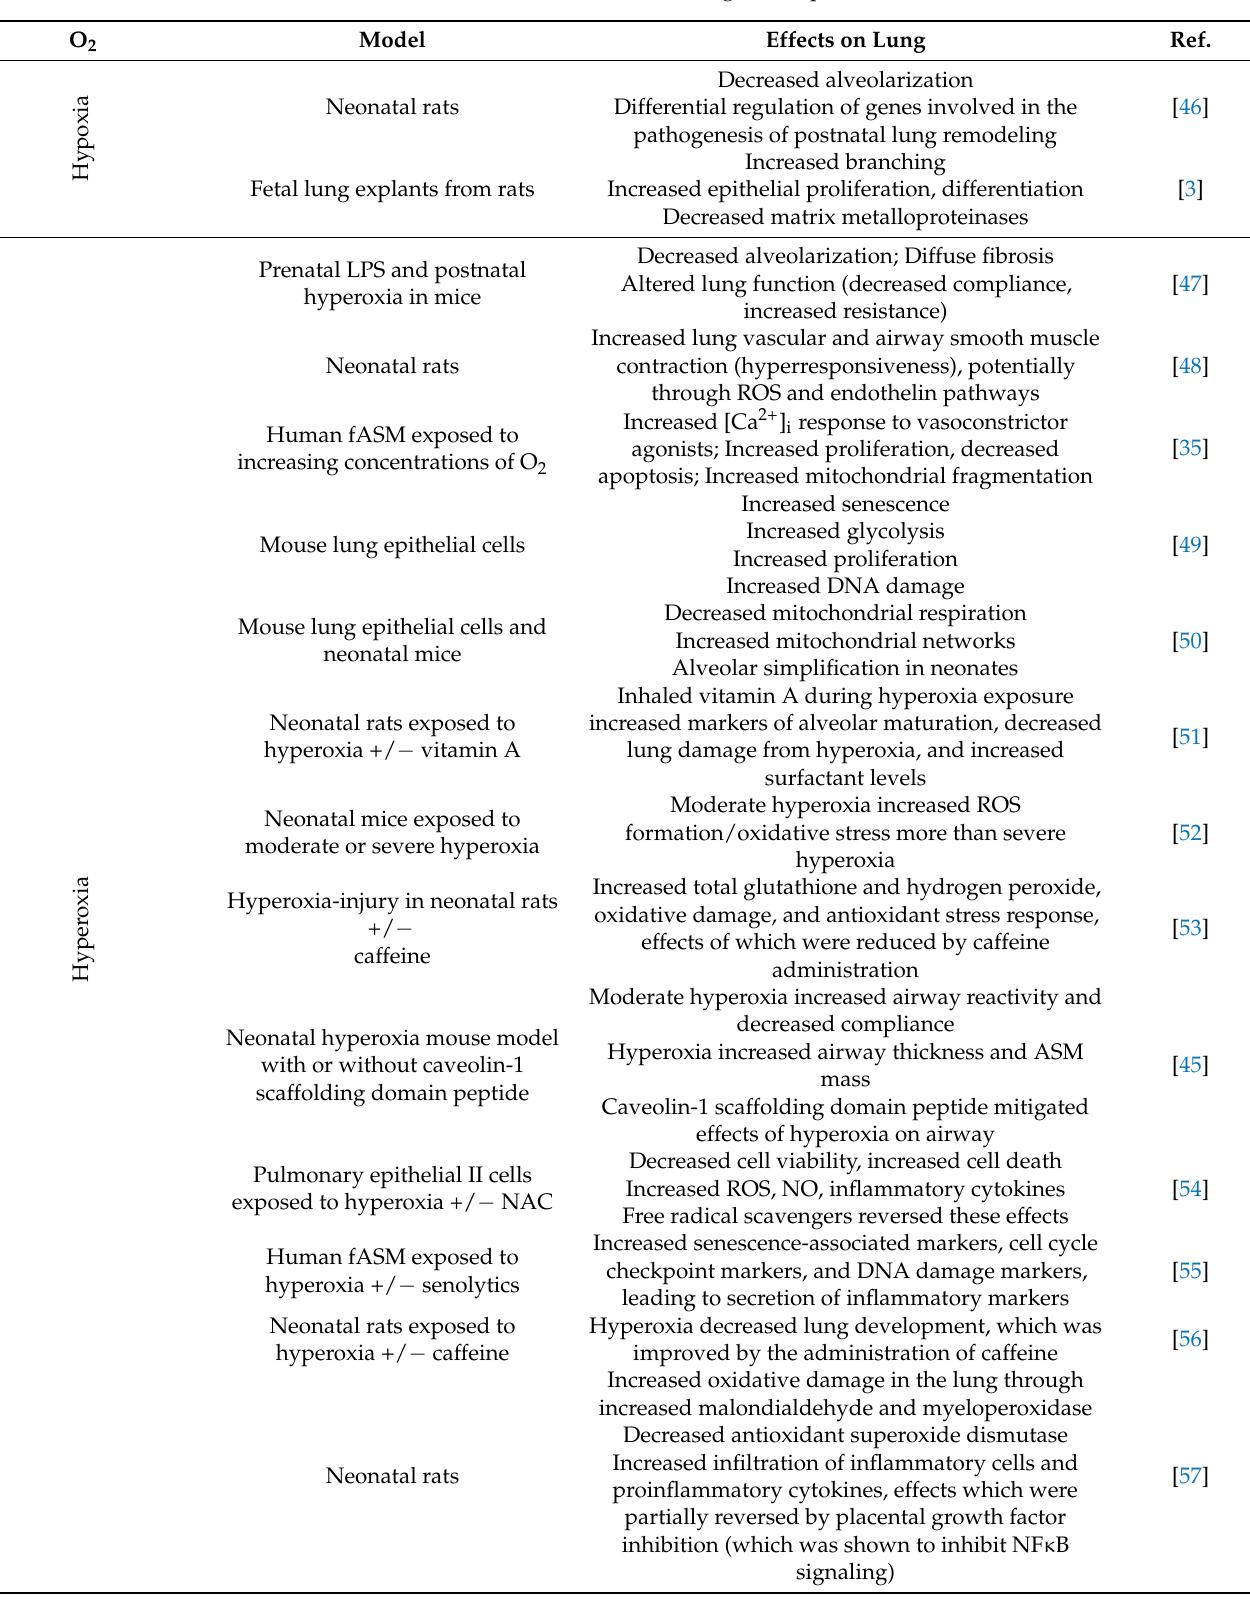
Table 1. Effects of O 2 on Neonatal Lung